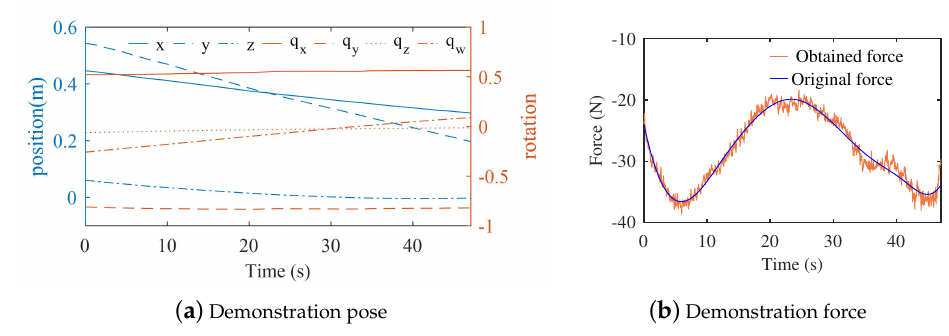
Figure 6. Data of the